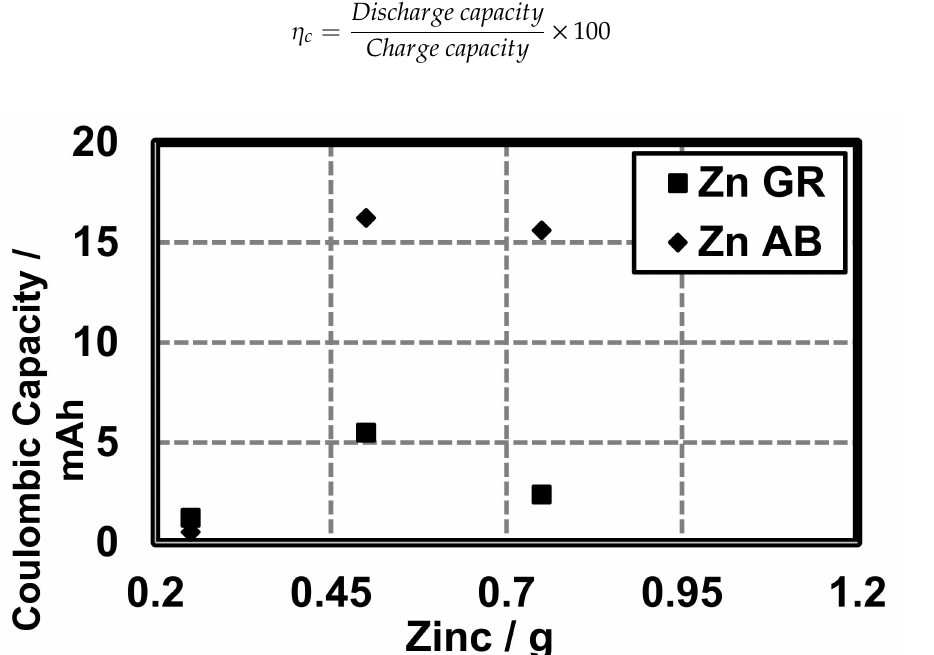
Figure 9. Coulombic capacity of cells made with variable amounts of zinc and di ff erent conductive additives (AB and GR).